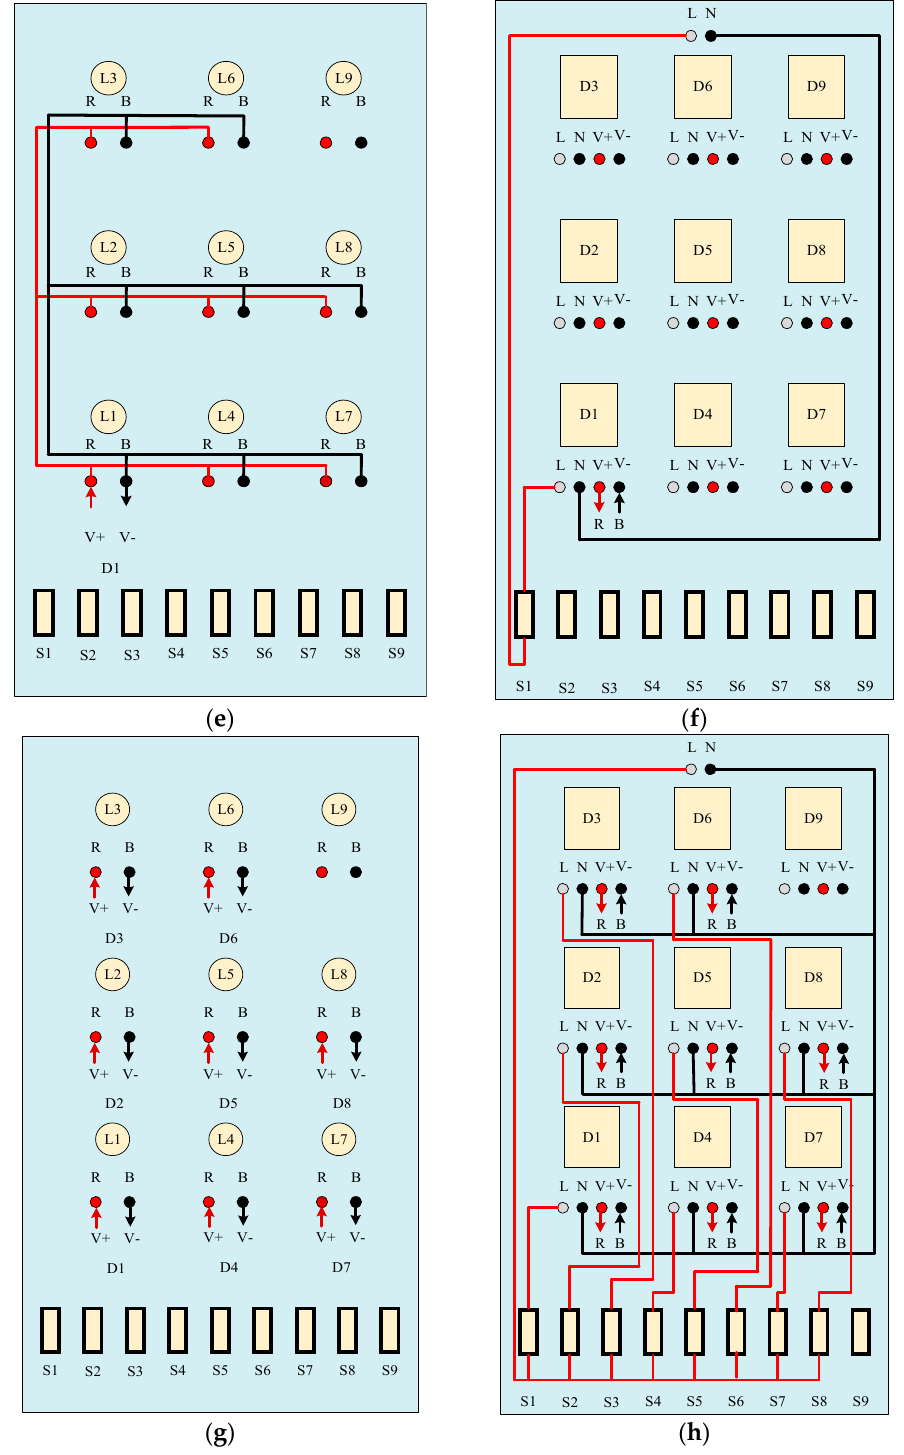
Figure 3. Layout circuit wiring diagram of the LED equipment of each layer. ( a ) Wiring diagram of LED lamp in case of one LED lamp; ( b ) Wiring diagram of LED driver in case of one LED lamp and one LED driver; ( c ) Wiring diagram of LED lamp in case of two LED lamps and two LED drivers; ( d ) Wiring diagram of LED driver in case of two LED lamps and two LED drivers; ( e ) Wiring diagram of LED lamp in case of eight LED lamps and one LED driver; ( f ) Wiring diagram of LED driver in case of eight LED lamps and one LED driver; ( g ) Wiring diagram of LED lamp in case of eight LED lamps and eight LED drivers; ( h ) Wiring diagram of LED driver in case of eight LED lamps and eight LED drivers.